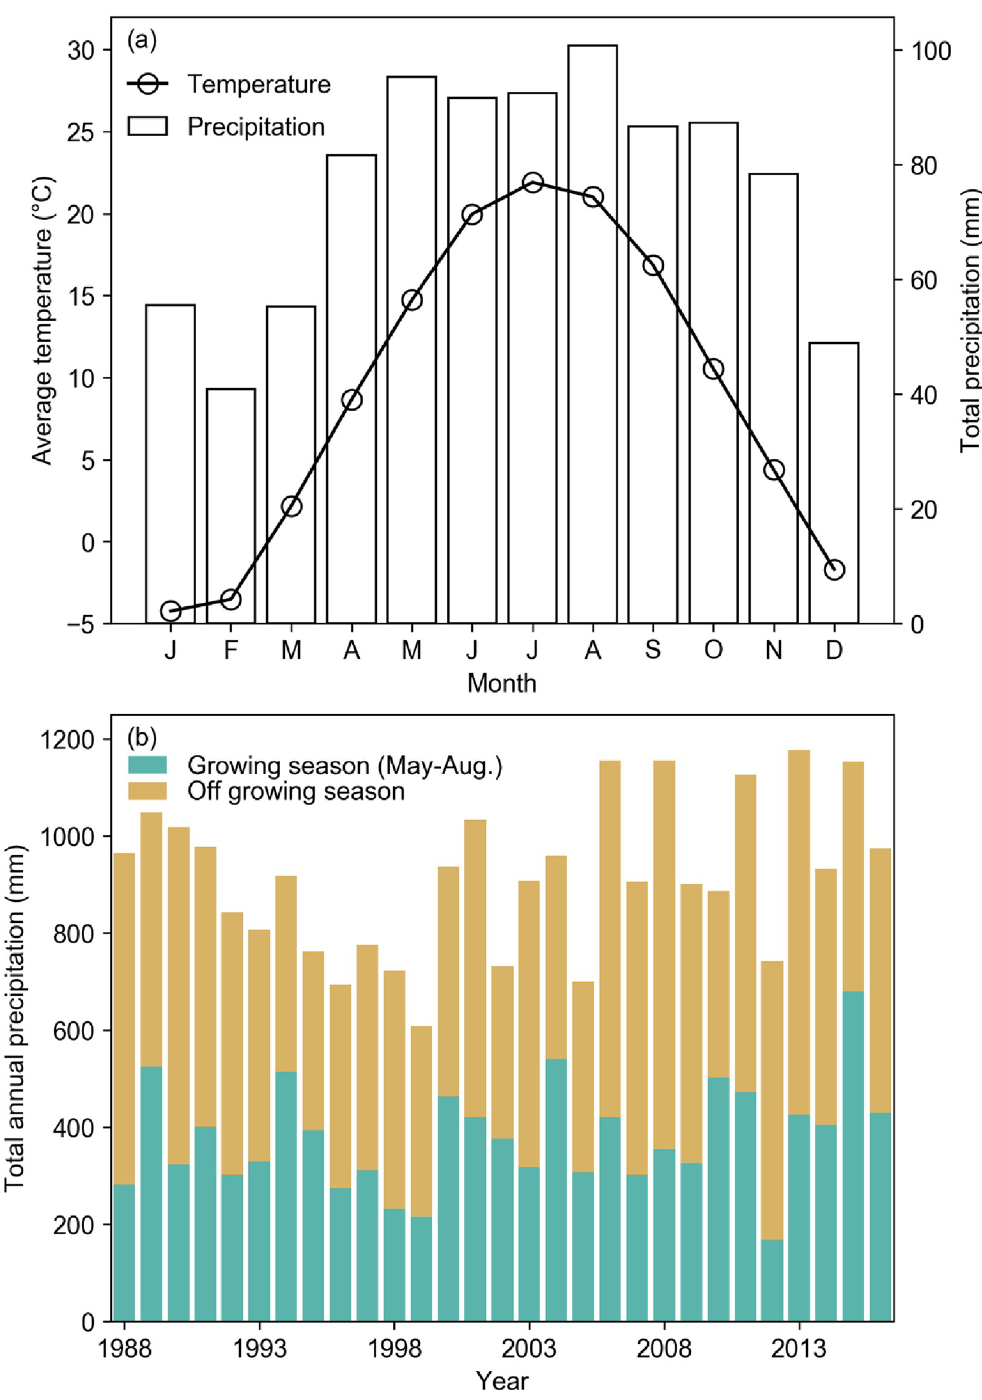
Fig 1. (a) Monthly distribution of average temperature and total precipitation, and (b) annual total precipitation in growing seasons (May-August) and off growing season in 1988–2016.